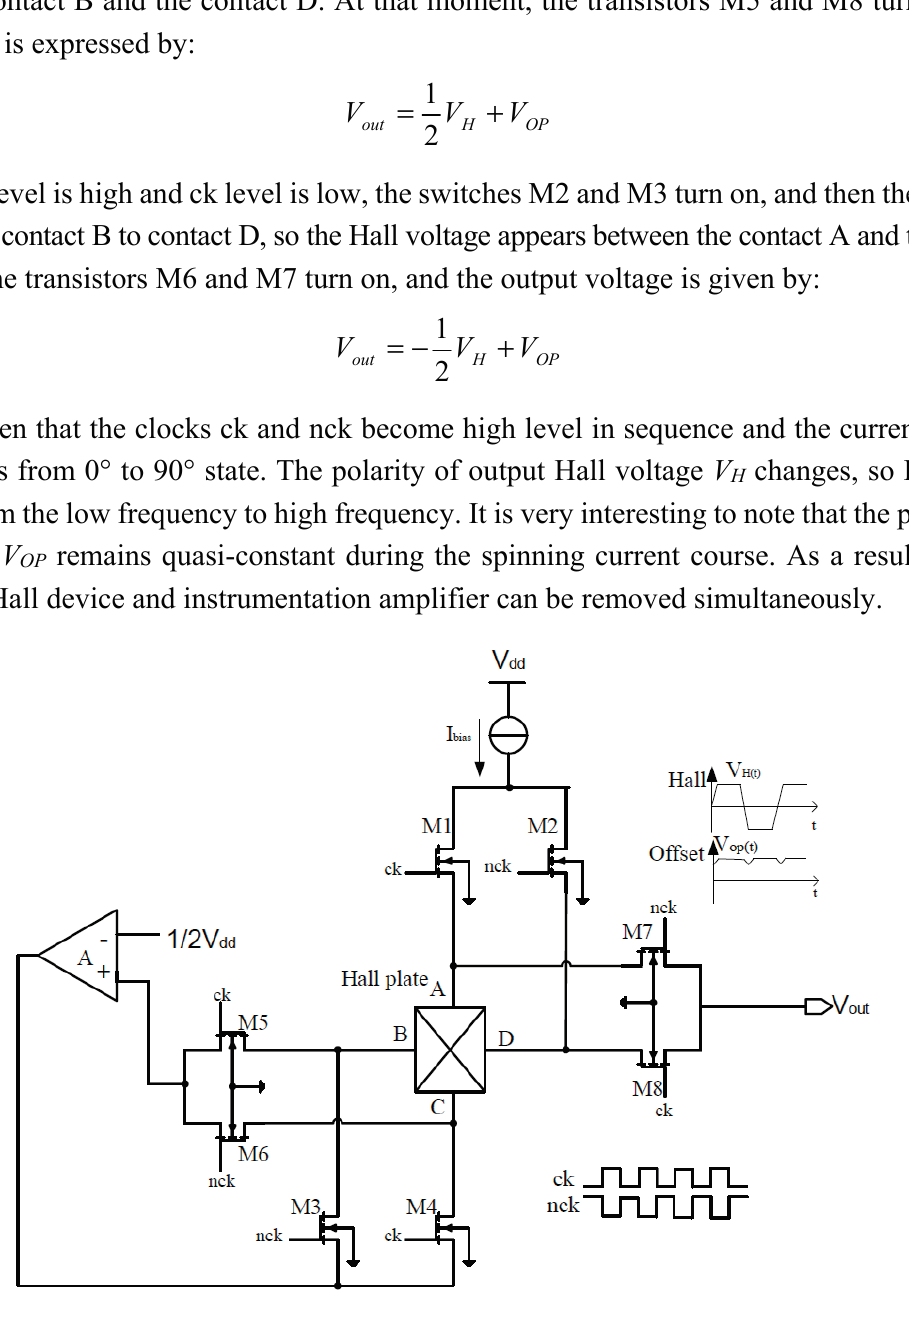
Figure 5. Circuit diagram of spinning current modulator of Hall